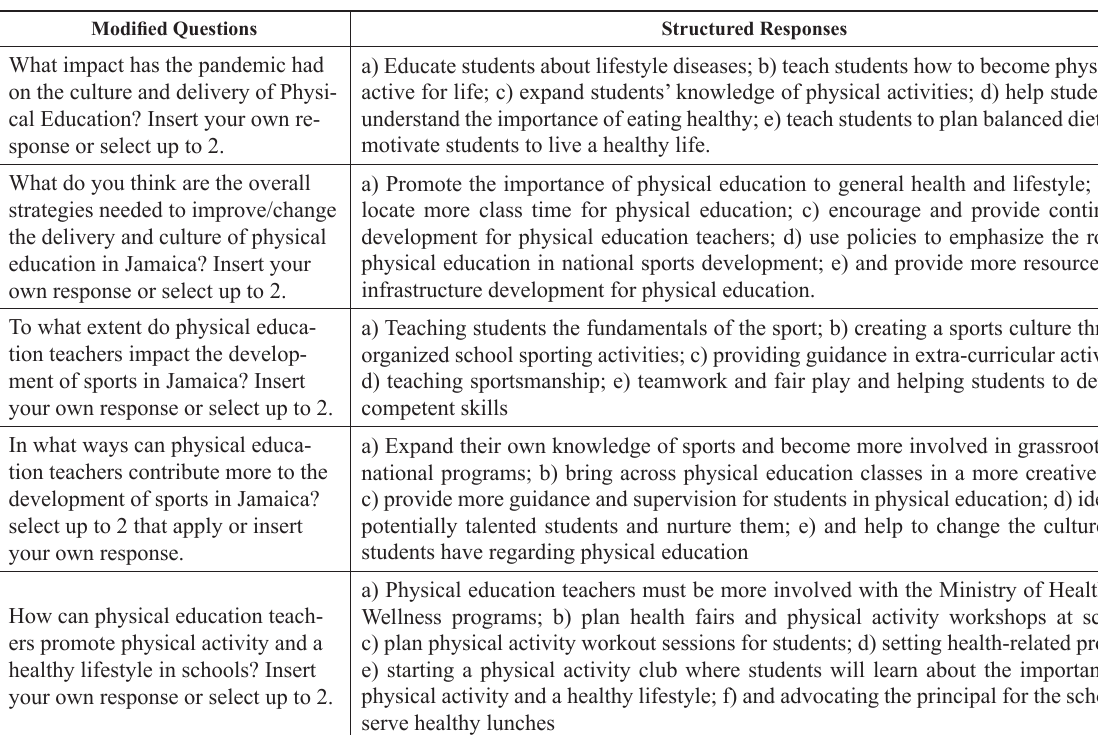
Table 2. Summary of the major data collection questions and structured